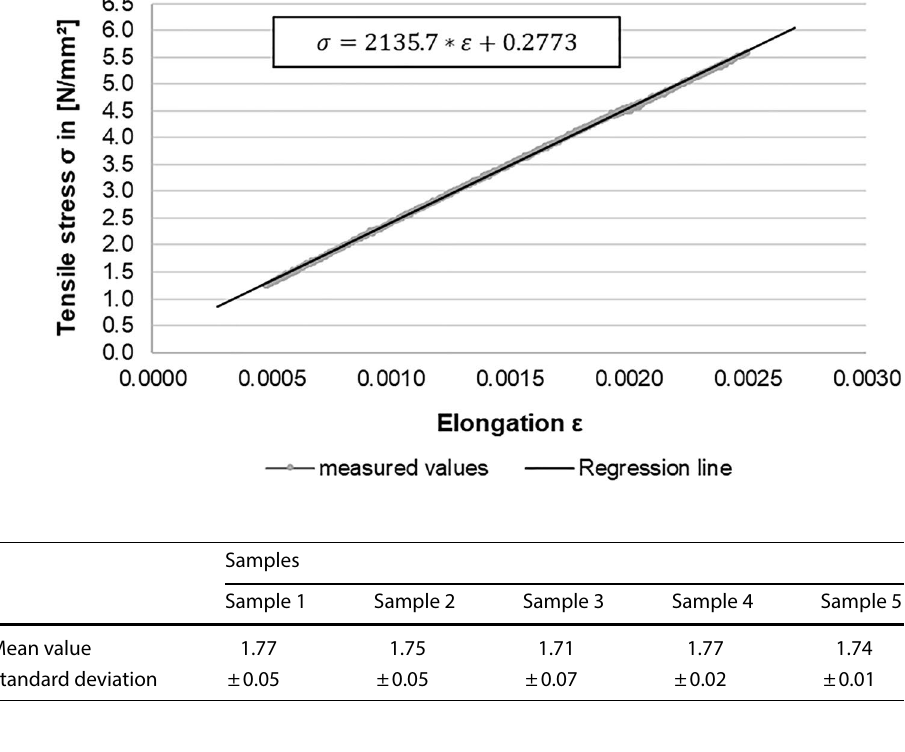
Table 7 Calculated average for the measured values of all printed test